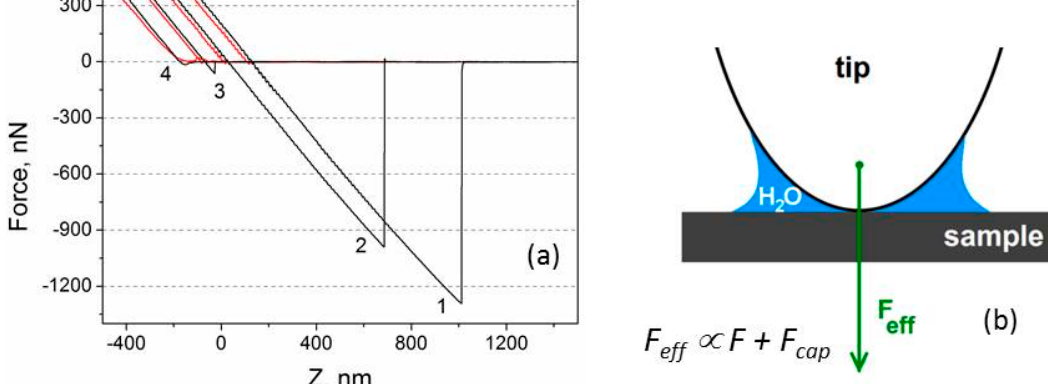
Figure 11. ( a ) The force–distance curves measured in different points on the DLN film (marked in the FF image in Figure 10b): (1) original film, (2) near the region of redeposited material, (3) in the region of redeposited material, (4) in the center of a crater, and ( b ) schematic of the capillary force action on Si tip.